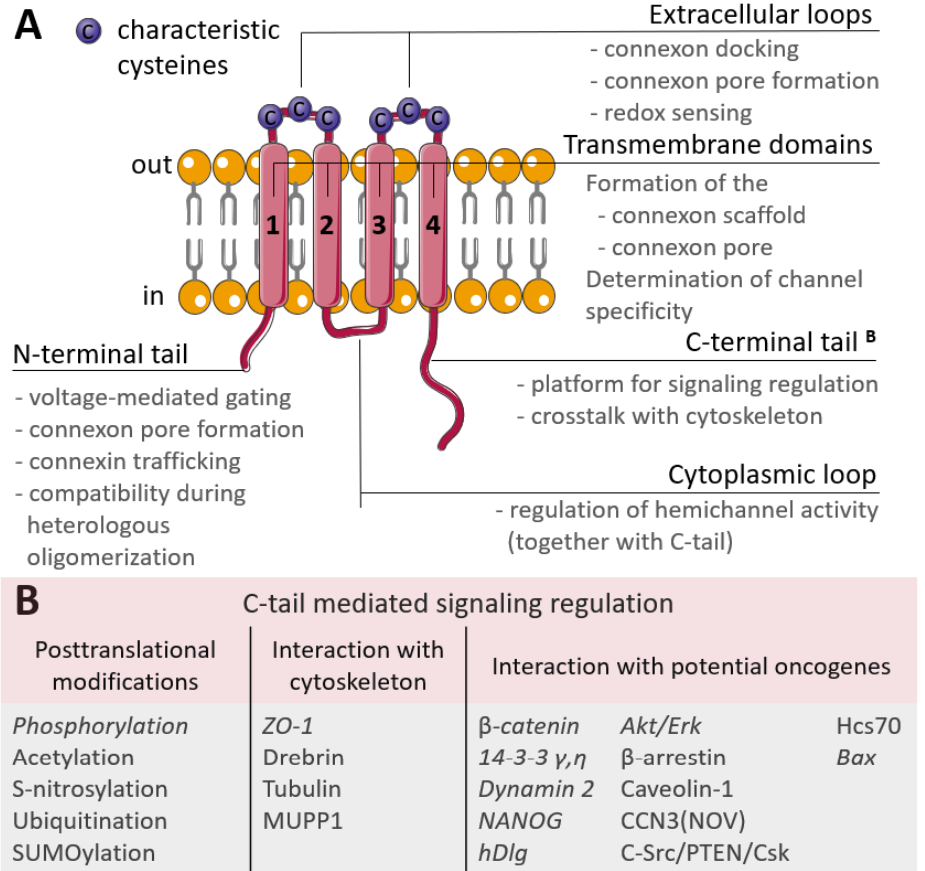
Figure 1. ( A ) Scheme of the connexin structure. Connexin is a tetraspan molecule which contains four transmembrane α -helices (1-4), two extracellular loops and one cytoplasmic loop; the amino- and carboxy-termini are located inside the cell. Transmembrane domains participate in the formation of the connexon scaffold and pore formation; extracellular loops are responsible for channel docking; the cytoplasmic loop and the N- and C-tails are the platform for the regulation of connexin functioning. ( B ) Participation of the connexin C-tail in regulation. The reported cancer-related signaling is represented in italic (explanations are in the text).